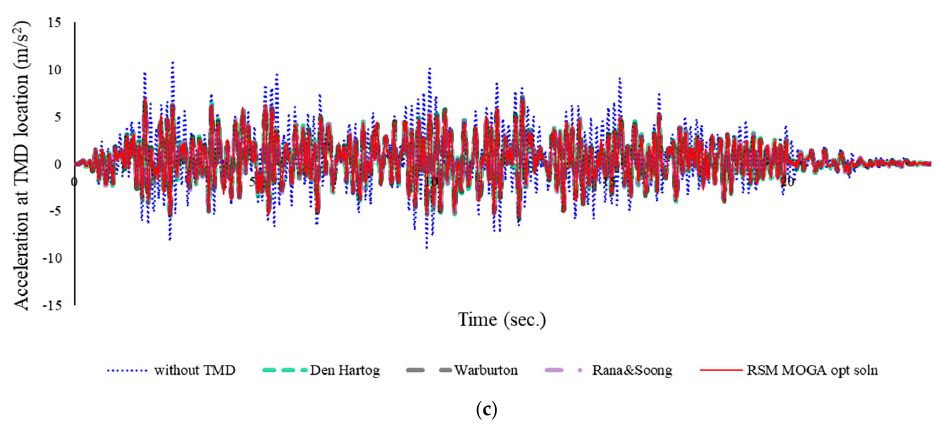
Figure 9. Comparison of the directional acceleration responses at the TMD installation location of the piping: ( a ) X direction; ( b ) Y direction; ( c ) Z direction.